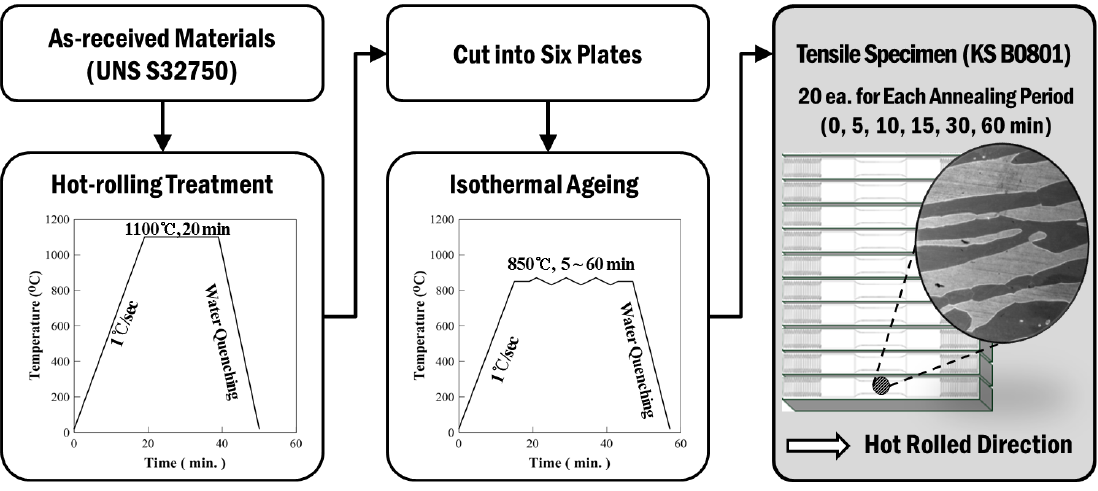
Figure 2. Heat treatment process for precipitation in super duplex stainless steel (SDSS)